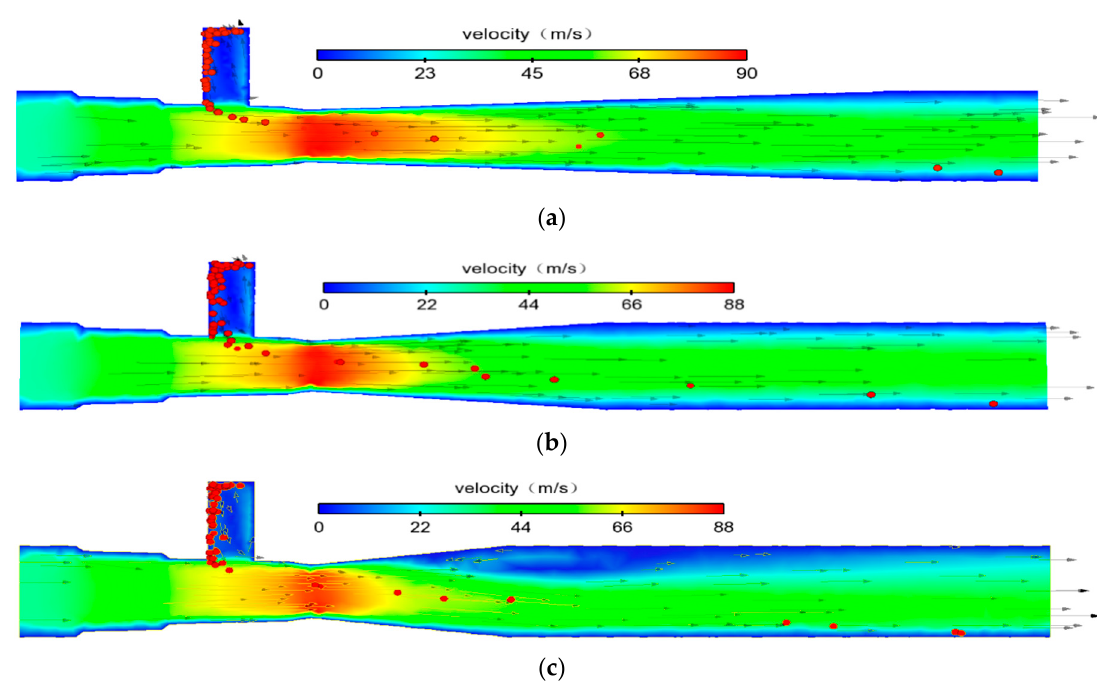
Figure 15. Velocity field nephogram: ( a ) type A, ( b ) type B, and ( c ) type C.